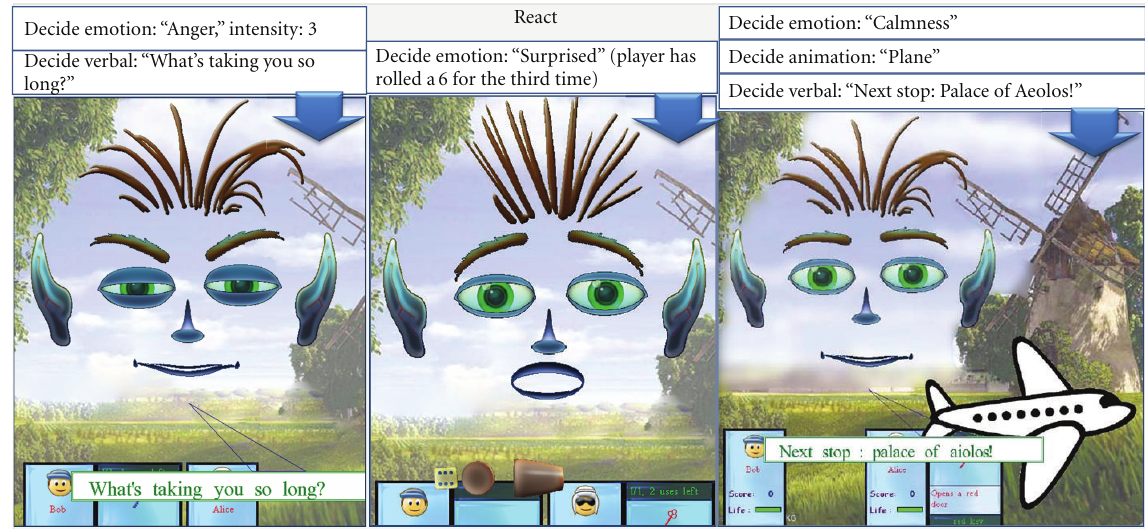
Figure 10: Examples of Amby reactions. At the top part, we display the decisions that correspond to each visual image.